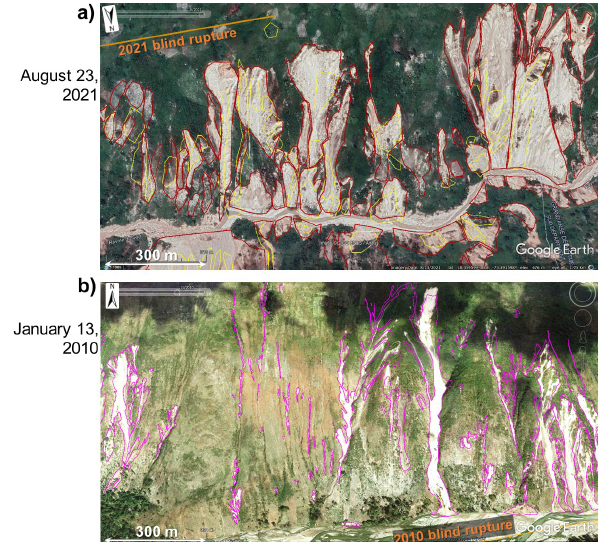
Figure 5. (a) GEPro view (© Google Earth Pro) of landslides trig- gered by the August 2021 earthquake. (b) GEPro view (© Google Earth Pro) of landslides induced by the January 2010 main shock (with landslide outlines by Harp et al.,